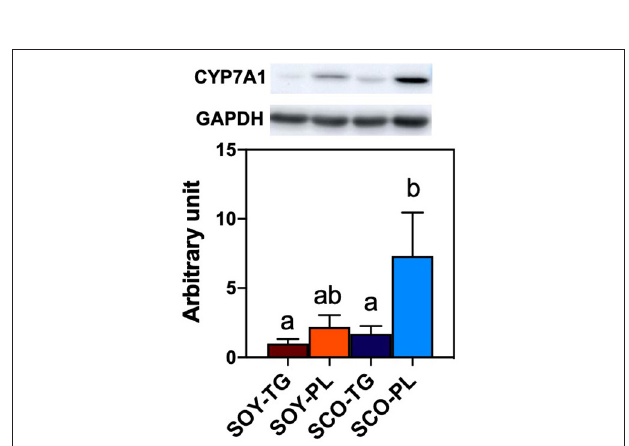
FIGURE 3 | Liver CYP7A1 protein expression level. Data represent the mean ± SEM ( n = 8). Different letters indicate significantly different at p < 0.05 (Tukey’s multiple comparison test). The protein expression level was determined using the GAPDH expression level for normalization. CYP7A1 protein expression levels are shown relative to those determined from the livers of mice in the SOY-TG group (set at 1). The bands of representative 4 sample/group are shown in Supplementary Figure 1 . CYP7A1, cytochrome P450 family 7 subfamily a polypeptide 1; GAPDH, glyceraldehyde 3-phosphate dehydrogenase; SCO-PL, scallop oil’s phospholipids fraction; SCO-TG, scallop oil’s triglyceride fraction; SOY-PL, soybean oil’s phospholipids fraction; SOY-TG, soybean